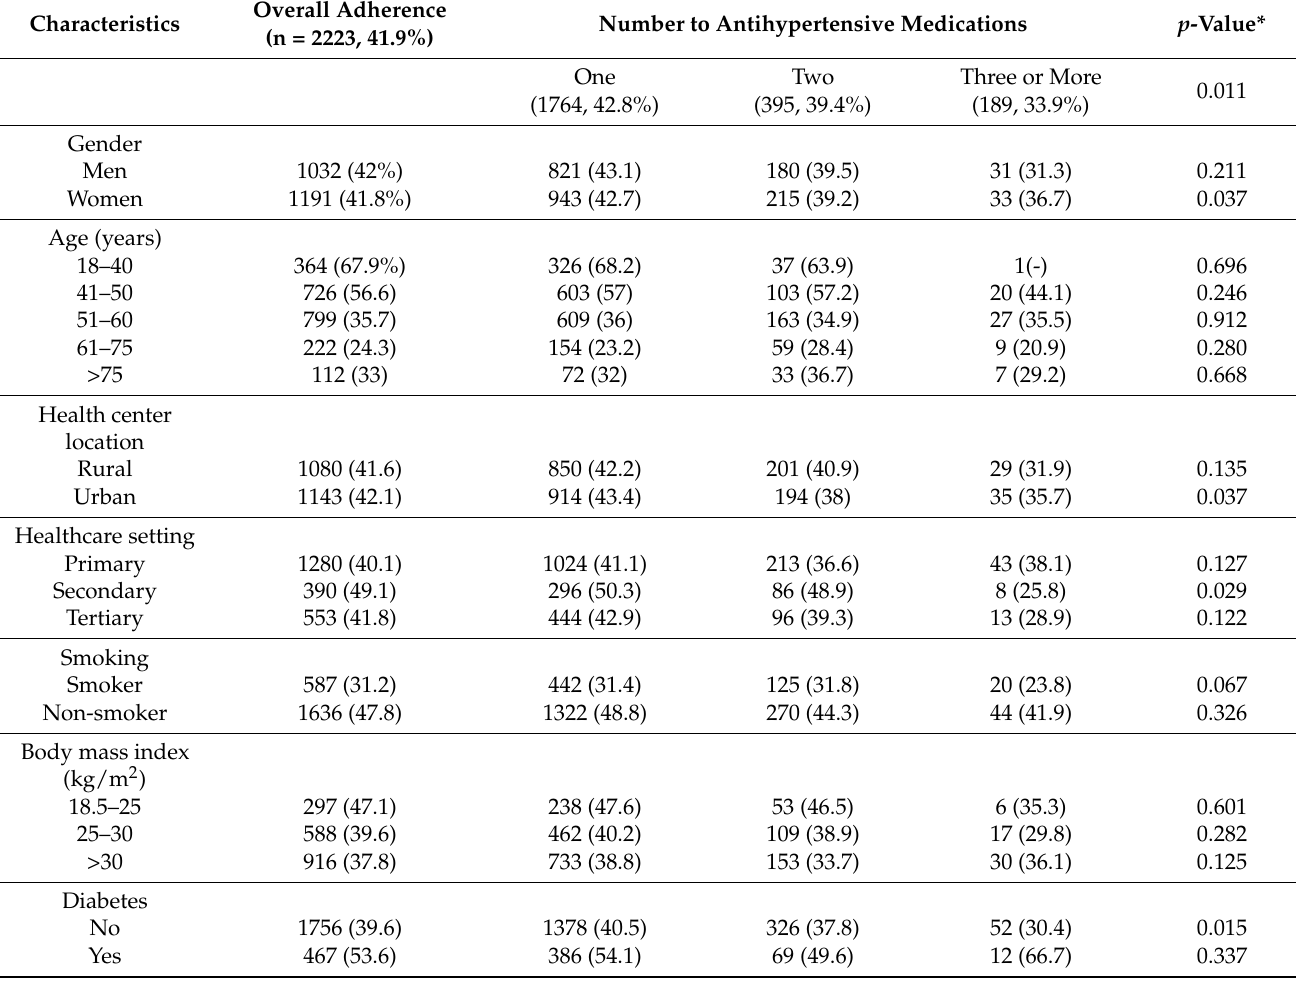
Table 3. Adherence to antihypertensive medication across subgroups at